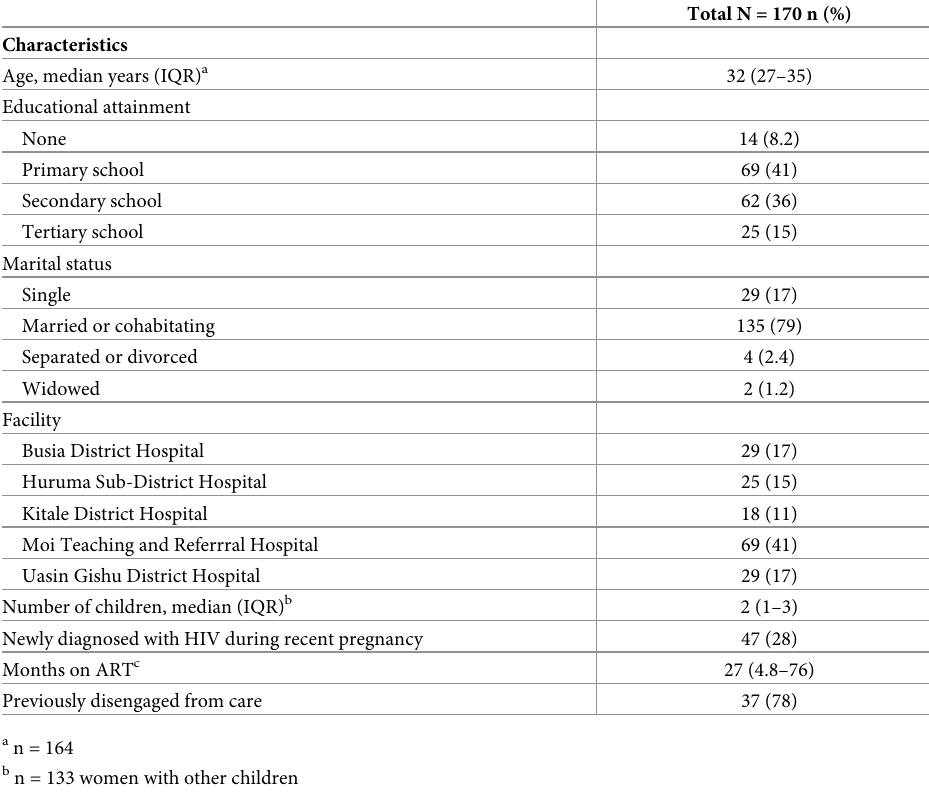
Table 1. Characteristics of WHIV at enrollment in the parent